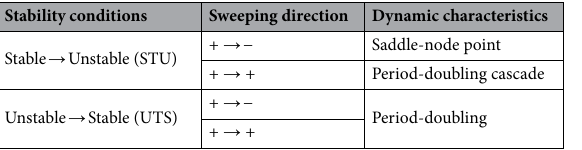
Table 3. Dynamic characteristics in the super- and sub-harmonic regimes based on frequency